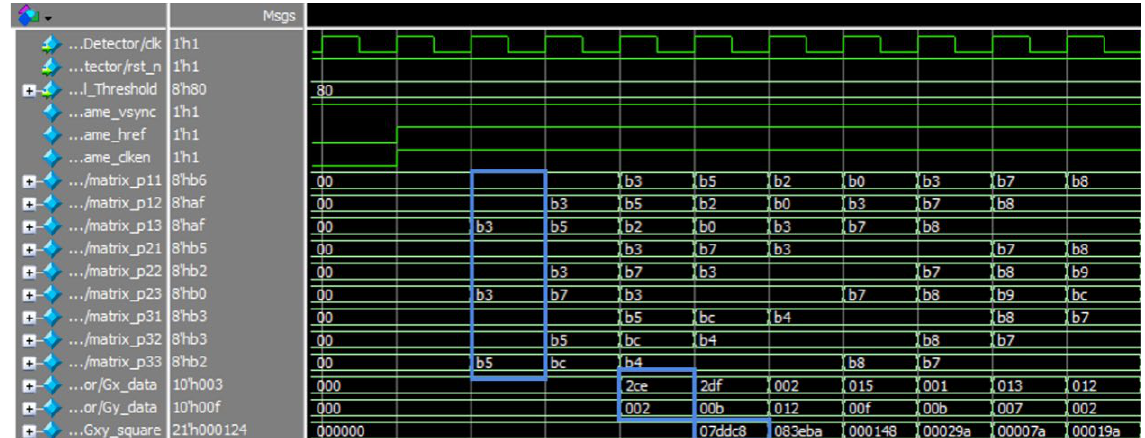
Figure 8. Sobel edge detection algorithm simulation module.